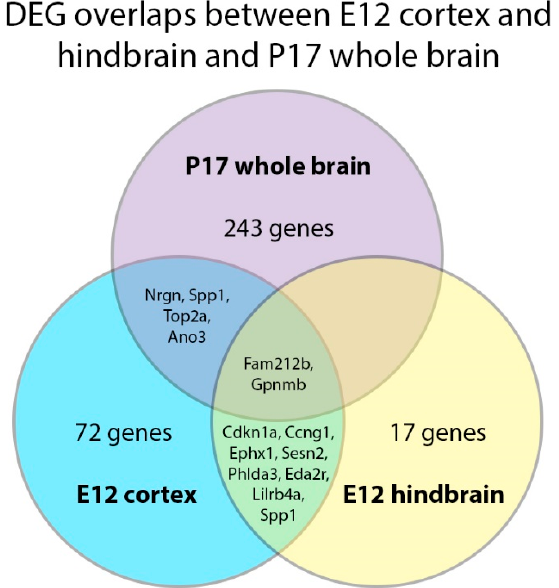
Figure 9. Overlaps between significant DEGs of the E12 cortex, E12 hindbrain, and P17 whole brain. DEGs with significant q -values were compared across the three RNAseq datasets. Very few DEGs overlapped between the P17 and E12 time points.